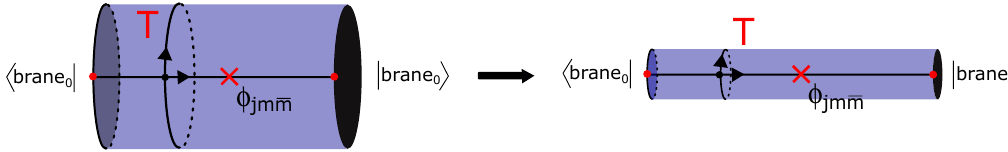
Figure 14 . Left: cylinder amplitude in WZW between vacuum branes j brane 0 i . Right: double scaling limit where the circumference of the cylinder T ! 0, as k ! 1 keeping the product (cid:12)xed kT (cid:24) C . A local WZW puncture gives a bilocal operator in the dimensionally reduced particle-on- a-group